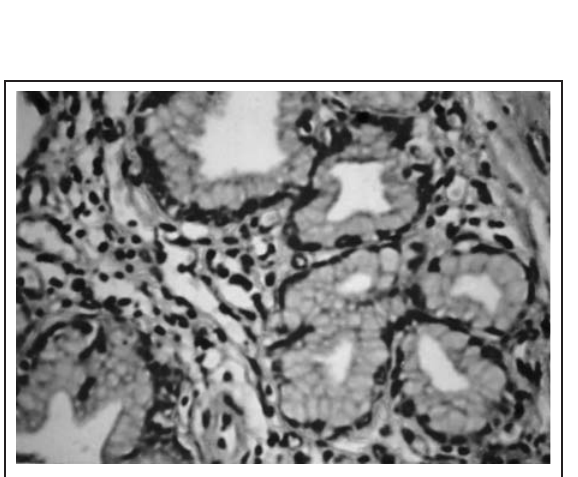
Figure 4. Metaplasia in chronic cholecystitis showing neutral mucin positivity (PAS-stain x 200). Figure 5. Metaplasia in chronic cholecystitis showing sulfated mucin positivity (Mild Methylation-AlcianBlue stain x 200).